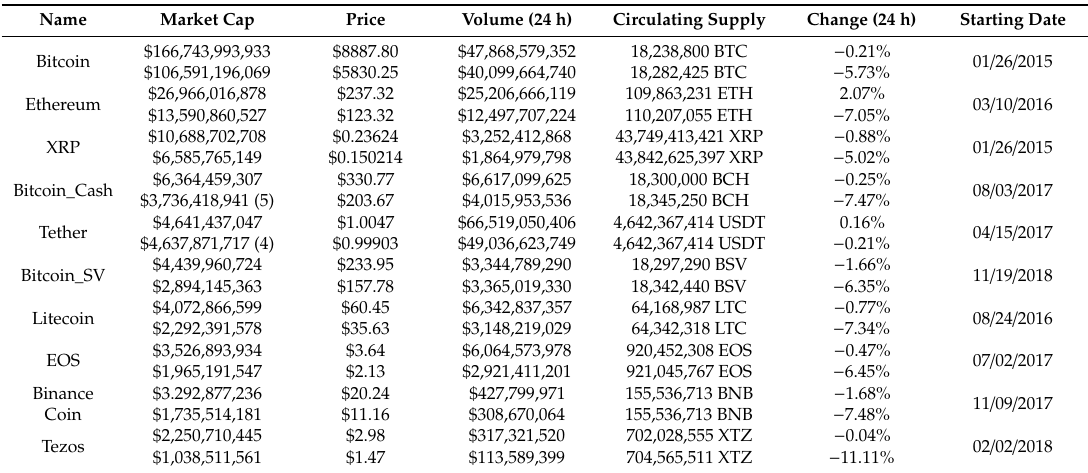
Table 1. Top 10 Cryptocurrencies by Market Capitalization (Date: 7 March 2020 / 22 March 2020) (Total market capitalization: $251.5 billion / $167.1 billion).